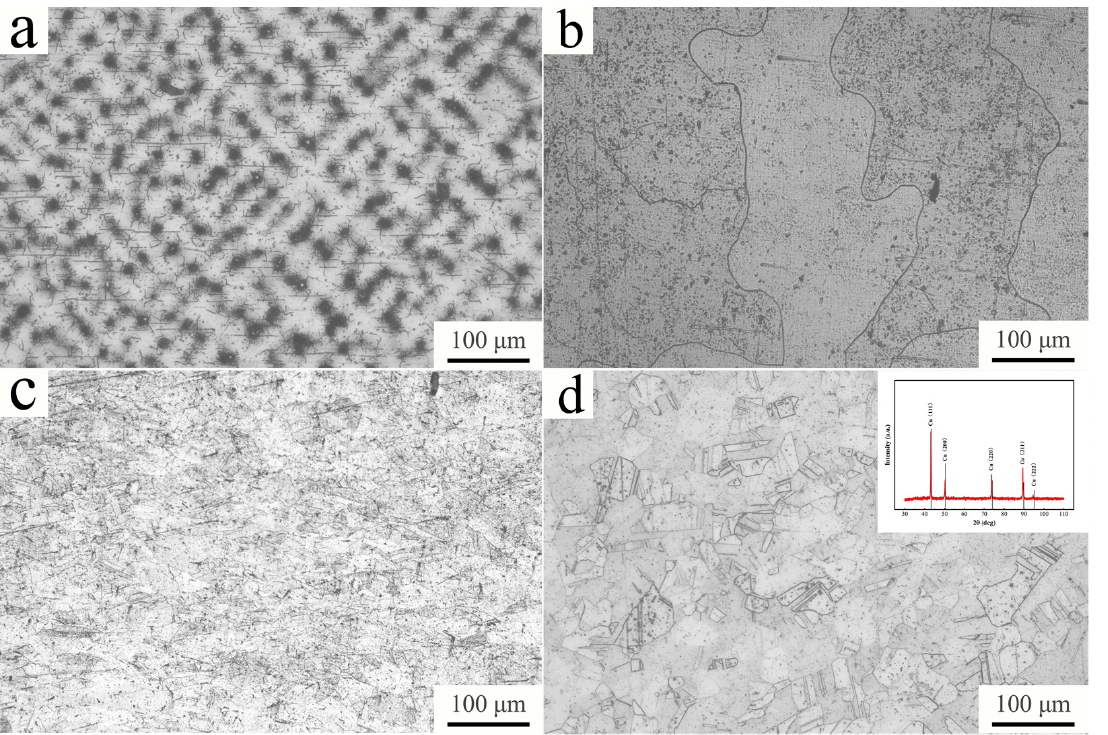
Figure 2. Metallograph of ( a ) casted, ( b ) homogenization, ( c ) hot-rolled, and ( d ) solid-solution-treated Cu-Ti-Cr-Mg alloy.